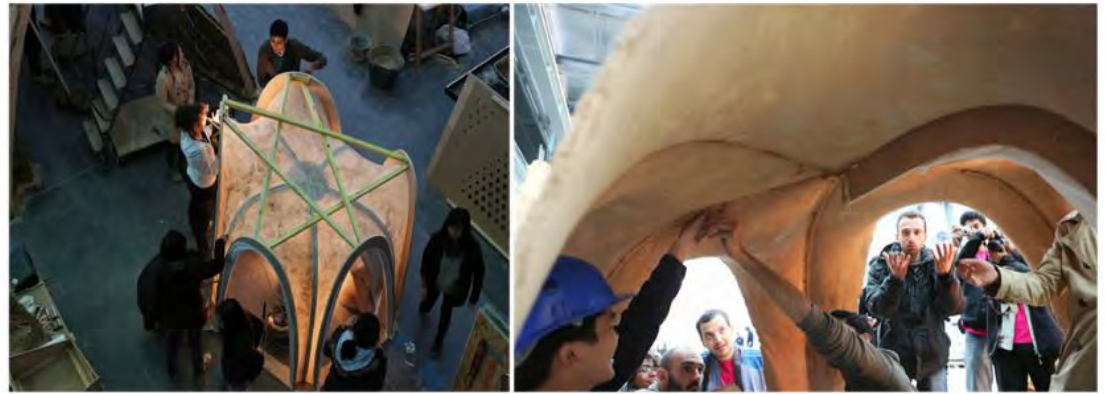
Figure 3. (a) First layers of claymix applied by hand by more than 3 people working simultaneously. (b) Removal of the wooden arches and fabric